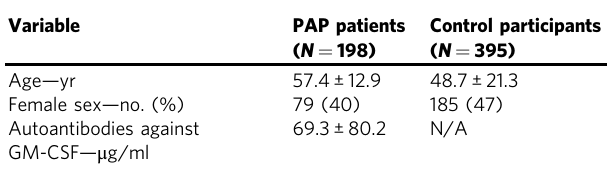
Table 1 Clinical characteristics of the patients and the controls at baseline.